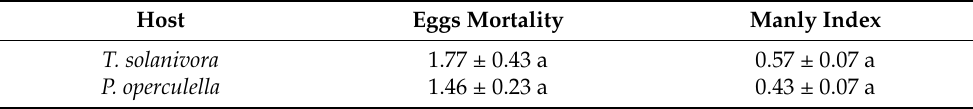
Table 2. Mean number (±SE) of killed eggs in the “choice” trials. Host Eggs